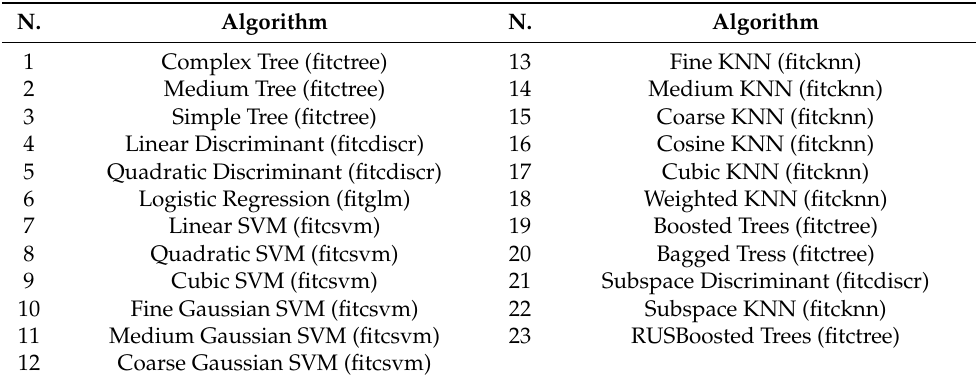
Table 1. List of classification algorithms (and related Matlab libraries).